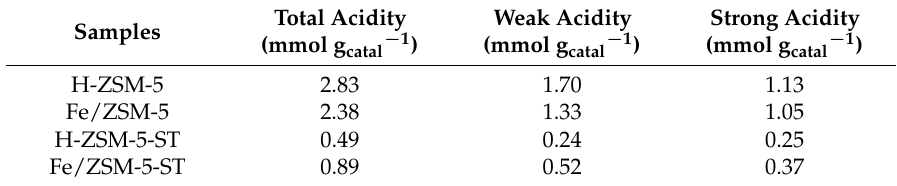
Figure 5. NH 3 -TPD spectra of the catalysts: ( a ) H-ZSM-5, ( b ) Fe/ZSM-5, ( c ) H-ZSM-5-ST and ( d ) Fe/ZSM-5-ST. Table 3. Acidity of H-ZSM-5, Fe/ZSM-5, H-ZSM-5-ST and Fe/ZSM-5-ST estimated on the groups of NH3-TPD profiles and from activity for reaction.